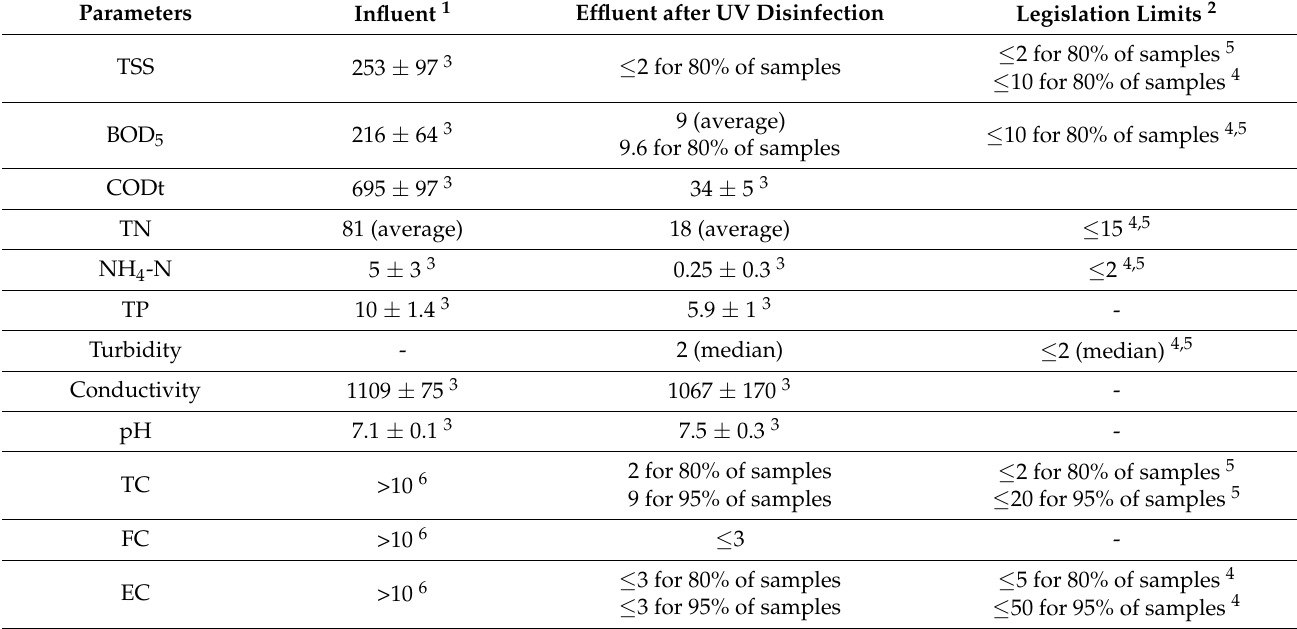
Table 4. Performance of the Hybrid MBR/UV pilot system (concentrations in mg/L, TC, FC, EC in cfu/100 mL, turbidity in NTU, conductivity in µ S/cm).